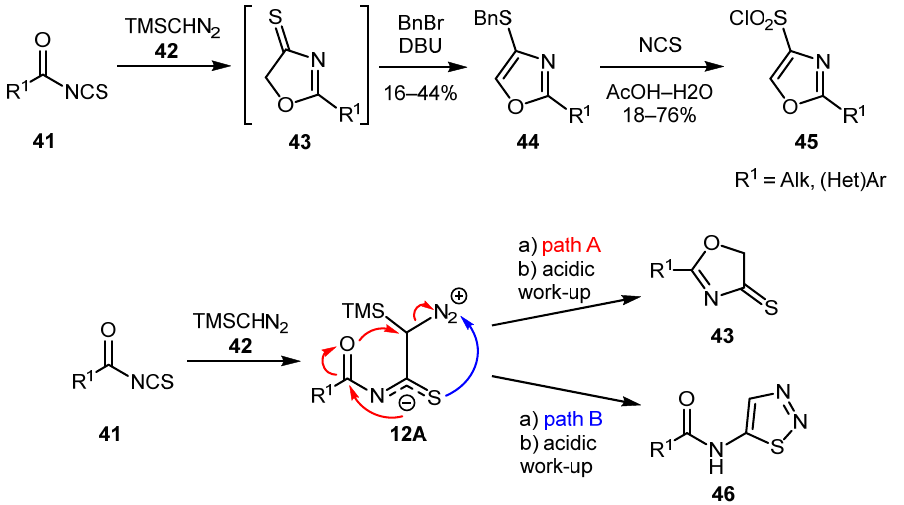
Scheme 11. Cu(OAc) 2 -catalyzed synthesis of oxazoles from α -ketooximes and diazo carbonyl compounds.